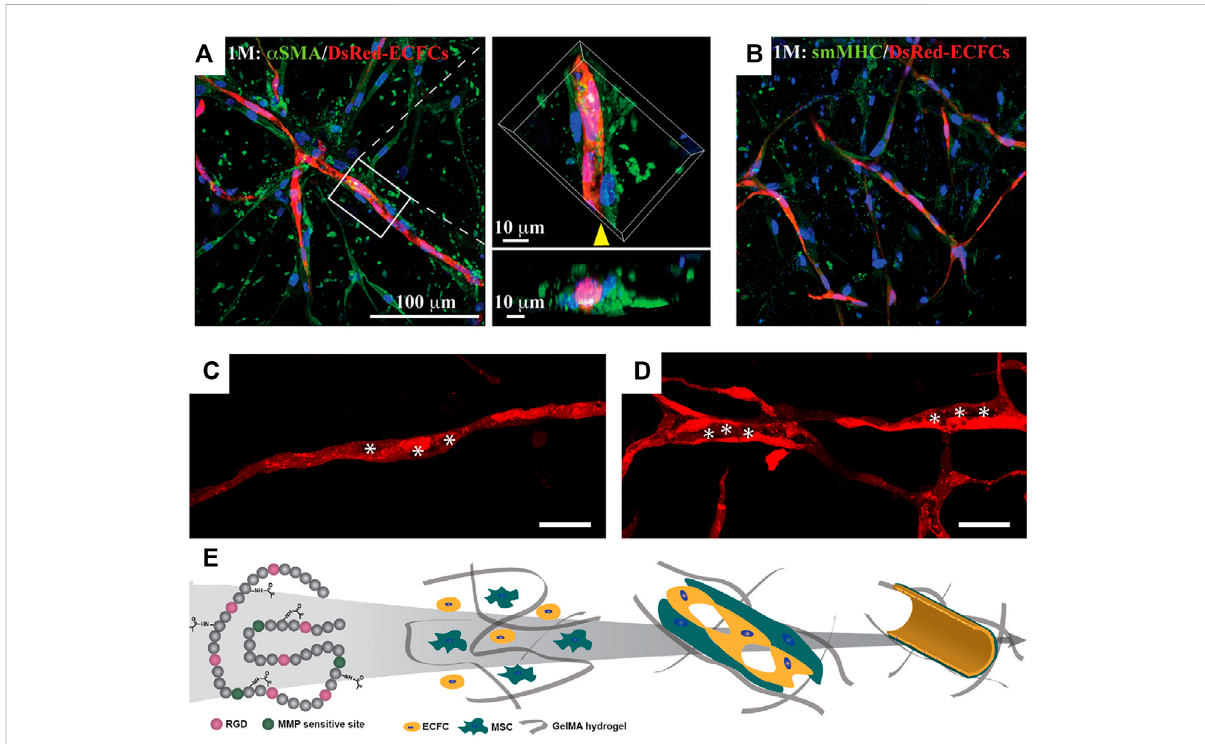
FIGURE 2 Vascular morphogenesis of human vascular progenitor cells cultured in GelMA hydrogels. Representative confocal images showing the spatial distribution of the DsRed-ECFC-lined capillaries surrounded by α -smooth muscle actin ( α SMA)-expressing MSCs (A) and smooth muscle myosin heavy chain (sm-MHC)-expressing mature pericyte (B) . (C,D) Representative images of progressive lumen formation by DsRed-labeled ECFCs in GelMA hydrogels. The images were taken on days 3 (C) and 10 (D) . The hollow structures representing small vacuoles, fused vacuoles, and tubule compartments were labeled with asterisks. Scale bar, 100 µm. (E) Schematic diagram depicting the vascular network formation by human ECFCsandMSCsinGelMA.TheintrinsicRGDandMMP-responsive motifsinthegelatinbackbonesallowcellspreading, proliferation,andmigration. ECFCs and MSCs in GelMA hydrogels undergo cell organization and matrix remodeling; both are critical for vascular morphogenesis. Intracellular vacuolesformandfuseforendotheliallumenformation.MSCsdifferentiateintopericyte-likecellsanddevelopperivascularcoveragetostabilizethe vascular networks (Chen et al.,